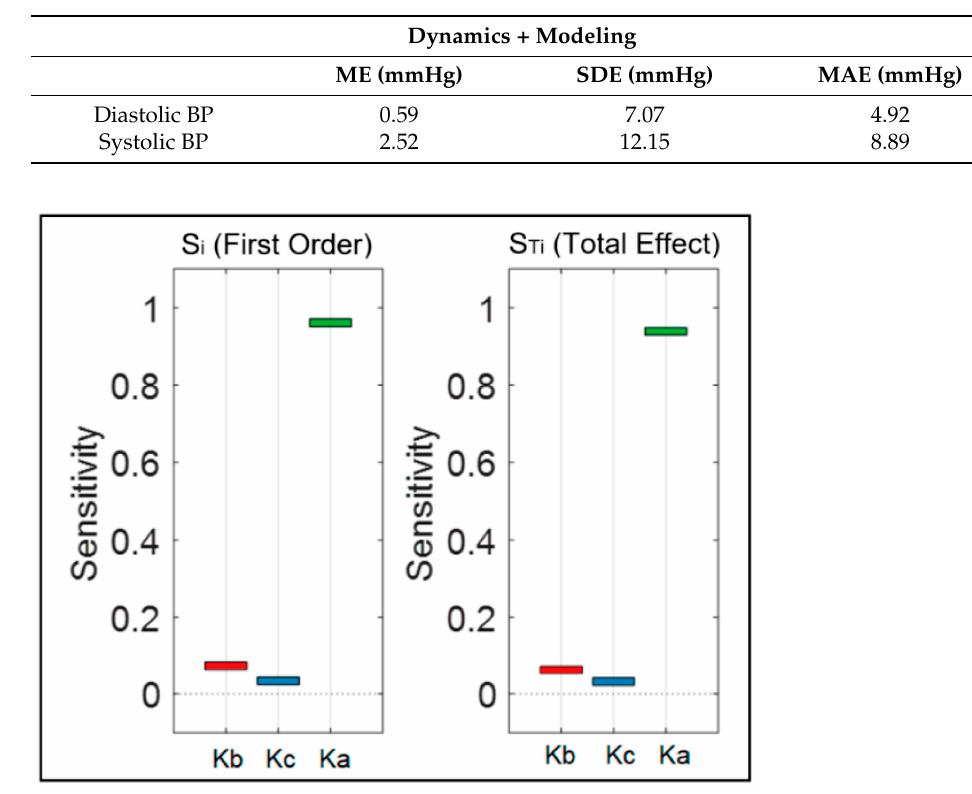
Table 5. Blood pressure estimation performance using IBI features and estimation from a calibrated mathematical model from 30 PPG waveforms. Three features are used for SBP and DBP. Estimation is carried out using the ANN described in the text, and the results are averaged over the 30 patients.